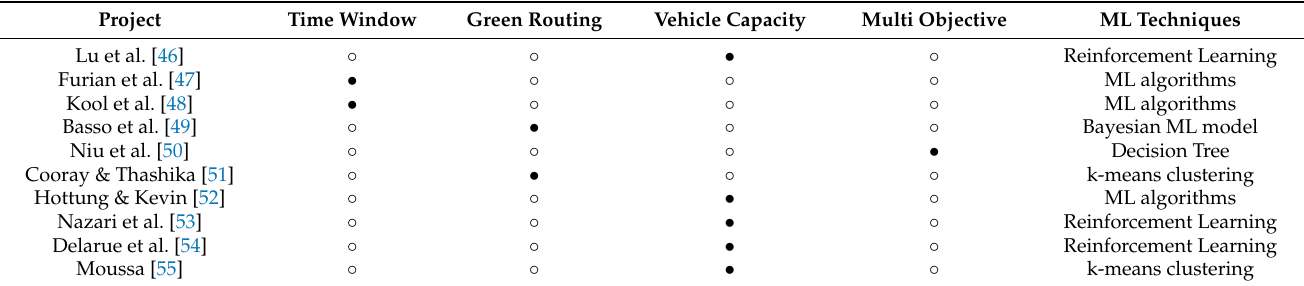
Table 2. ML-based Routing Services Features Comparison